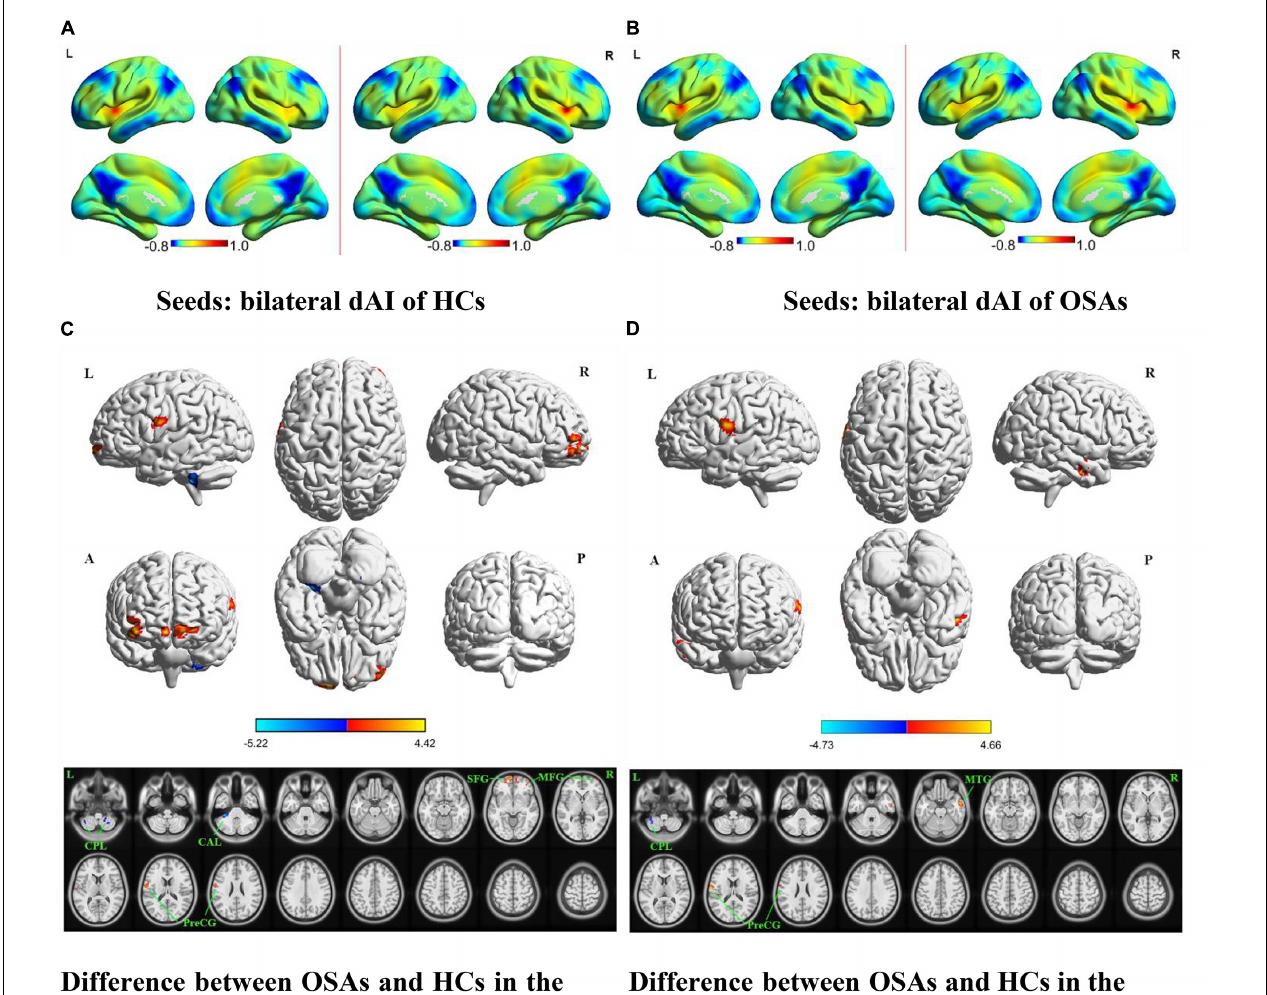
FIGURE 1 | The spatial distribution of the FC maps of the bilateral dAI in the two groups and between-group comparisons of the rs-FC of the bilateral dAI. The FC patterns of the bilateral dAI in the HC and OSA groups are shown in (A,B) , respectively. Color bars indicate z -values; warmer colors indicate higher z -values relative to the whole-brain average, while colder colors indicate lower z -values. (C) Denotes the altered FC based on the left dAI seed in OSAs relative to HCs. (D) Denotes the altered FC based on the right dAI seed in OSAs relative to HCs (voxel-level P < 0.001, AlphaSim corrected). Color bars indicate t-scores; warm colors indicate areas where the FC value in OSAs is greater than that in HCs, while cold colors indicate the opposite. HCs, healthy controls; OSAs, patients with obstructive sleep apnea; dAI, dorsal anterior insula; FC, functional connectivity; SFG, superior frontal gyrus; MFG, middle frontal gyrus; MTG, middle temporal gyrus;